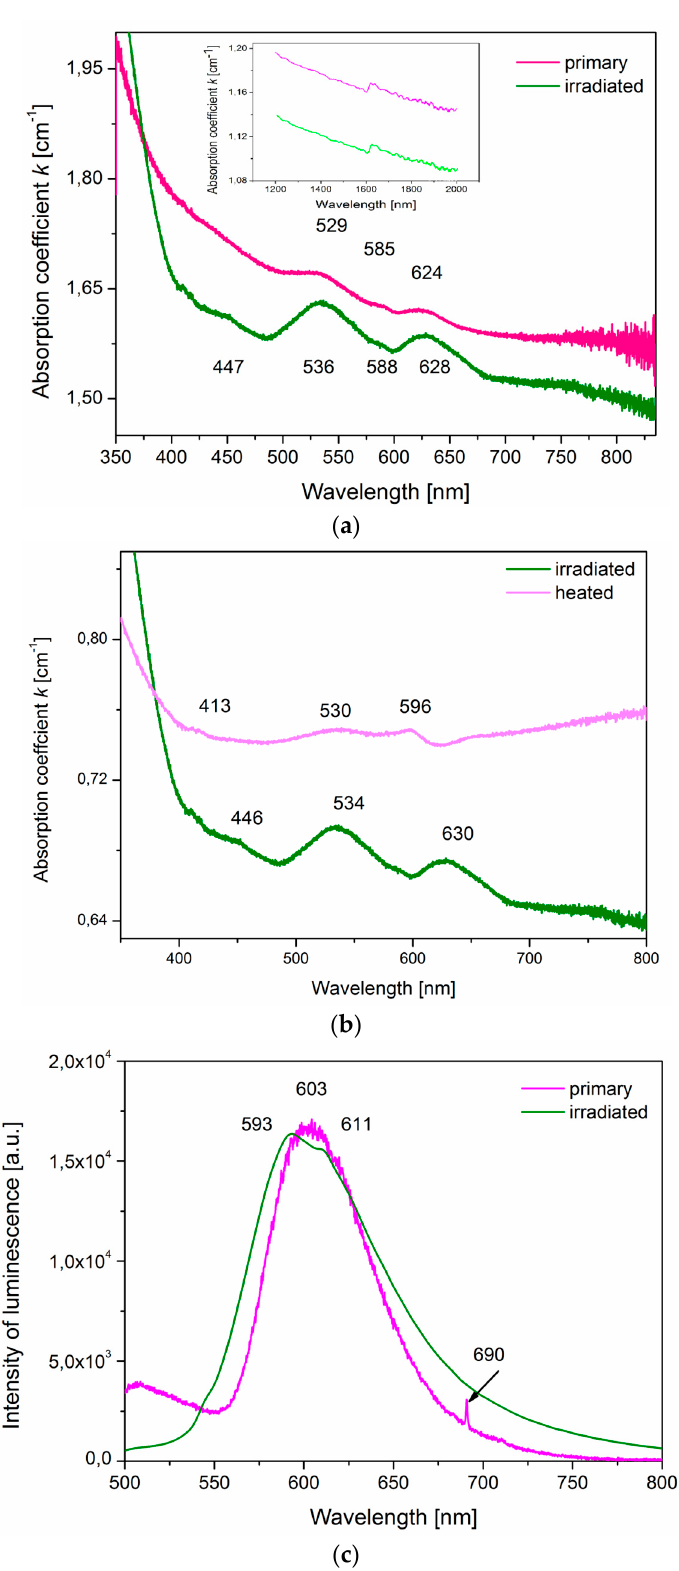
Figure 4. ( a ) Absorption spectra of primary and irradiated sample 3 measured at T = 7 K. ( b ) Absorption spectra of irradiated and heated sample 14 measured at T = 7 K. ( c ) Emission spectra of primary and irradiated sample 3 measured at T = 7 K.